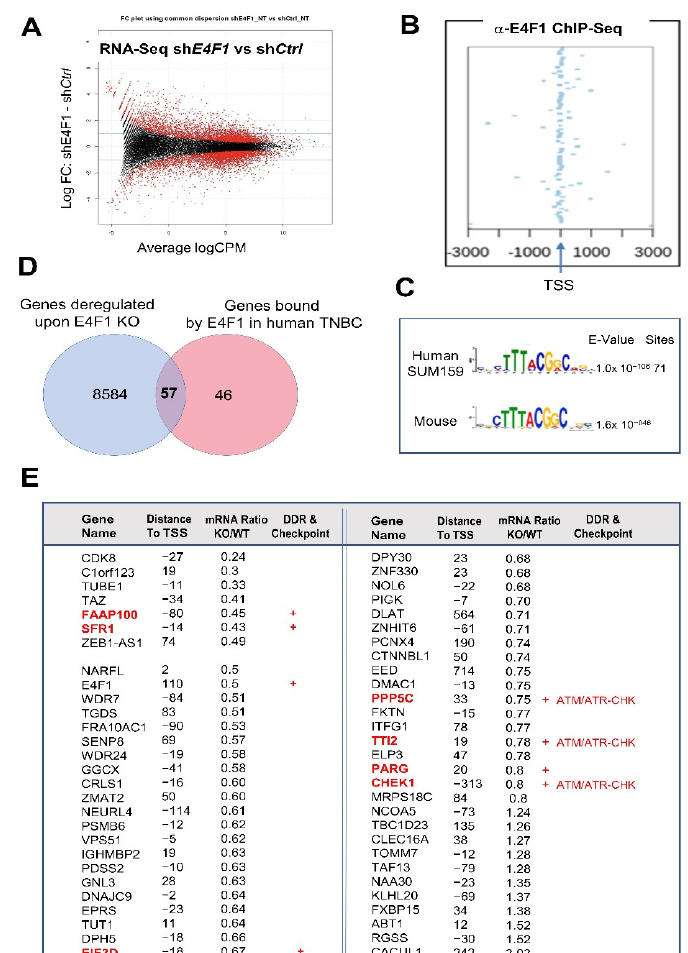
Figure 2. E4F1 directly controls a limited set of genes in the TNBC cell line SUM159, including a sub-program involved in the ATM/ATR-CHEK signaling pathway. ( A )—Fold change plot of differentially expressed genes, assessed by RNA-Seq, in SUM159 cells four days after the initial exposure to either sh Ctrl or sh E4F1 . The expression of a large set of genes is moderately deregulated in E4F1-depleted cells compared to control; ( B )—Identification of E4F1 target genes by ChIP-Seq. E4F1 ChIP-Seq read densities in the 3 kb regions surrounding the Transcription Start Sites (TSS) of the closest genes located nearby E4F1 binding sites, as identified in SUM159 cells. Out of the 116 ChIP-Seq peaks identified by ChIP-Seq in SUM159 cells ( n = 2; Tables S1–S3, Supplementary Materials), 102 were in these 3kb regions and 94 in promoters, indicating that E4F1 is mainly located nearby or on the TSS of its target genes; ( C )—MEME logo sequence analysis of the DNA fragments bound by E4F1 in SUM159 cells reveals a human E4F1 consensus motif that is similar to the Mouse E4F1 consensus motif previously identified by our laboratory [17]; ( D )—Venn diagram of the overlap between all of the E4F1 bound genes identified by ChIP-Seq in SUM159 cells (GSE128104 (in red)) and genes differentially expressed ( p < 0.05) between SUM159 cells treated with either sh Ctrl or sh E4F1 (GSE128099 (in blue)). These genome-wide analyses were performed at a time where all of the cells treated with shRNAs were still viable (annexin-V negative) and still actively growing. The overlap defines a set of 57 genes directly bound and regulated by E4F1 in SUM159; ( E )—List of the 57 E4F1 direct target genes as defined in panel D. Table provides information about the differential expression of transcripts in SUM159 cells treated with either sh Ctrl or sh E4F1 (Ratio KO/WT), the distance of the E4F1 consensus motif to the transcription start site (TSS) of the gene, and whether these genes code for factors involved in cellular stress response and checkpoints (red+) including proteins involved in the ATM/ATR-CHK kinases axis (CHK1, PPP5C and